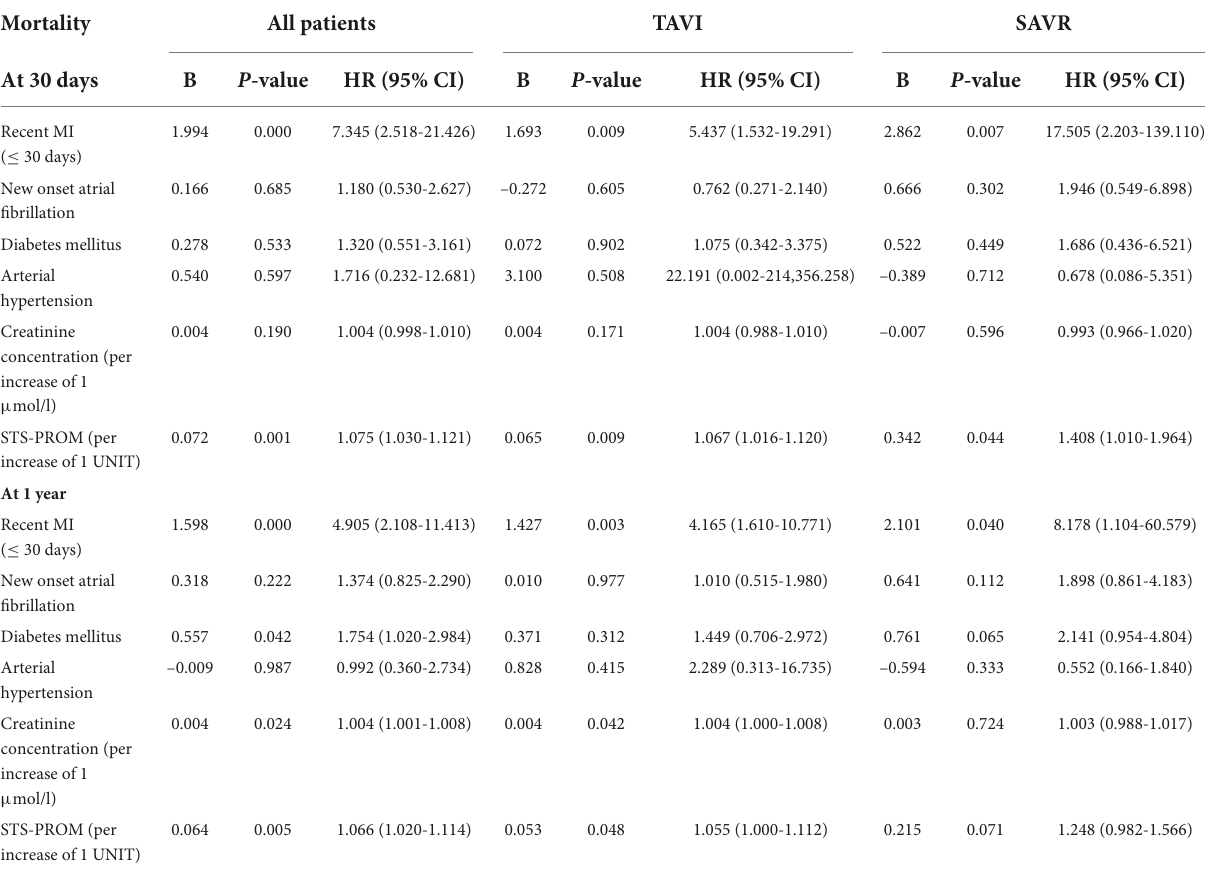
SAVR,surgicalaorticvalvereplacement;TAVI,transcatheteraorticvalveimplantation;TIA,transientischemicattack,PSM,propensityscorematched. TABLE 4 Predictors of mortality at 30 days and 1 year (Cox